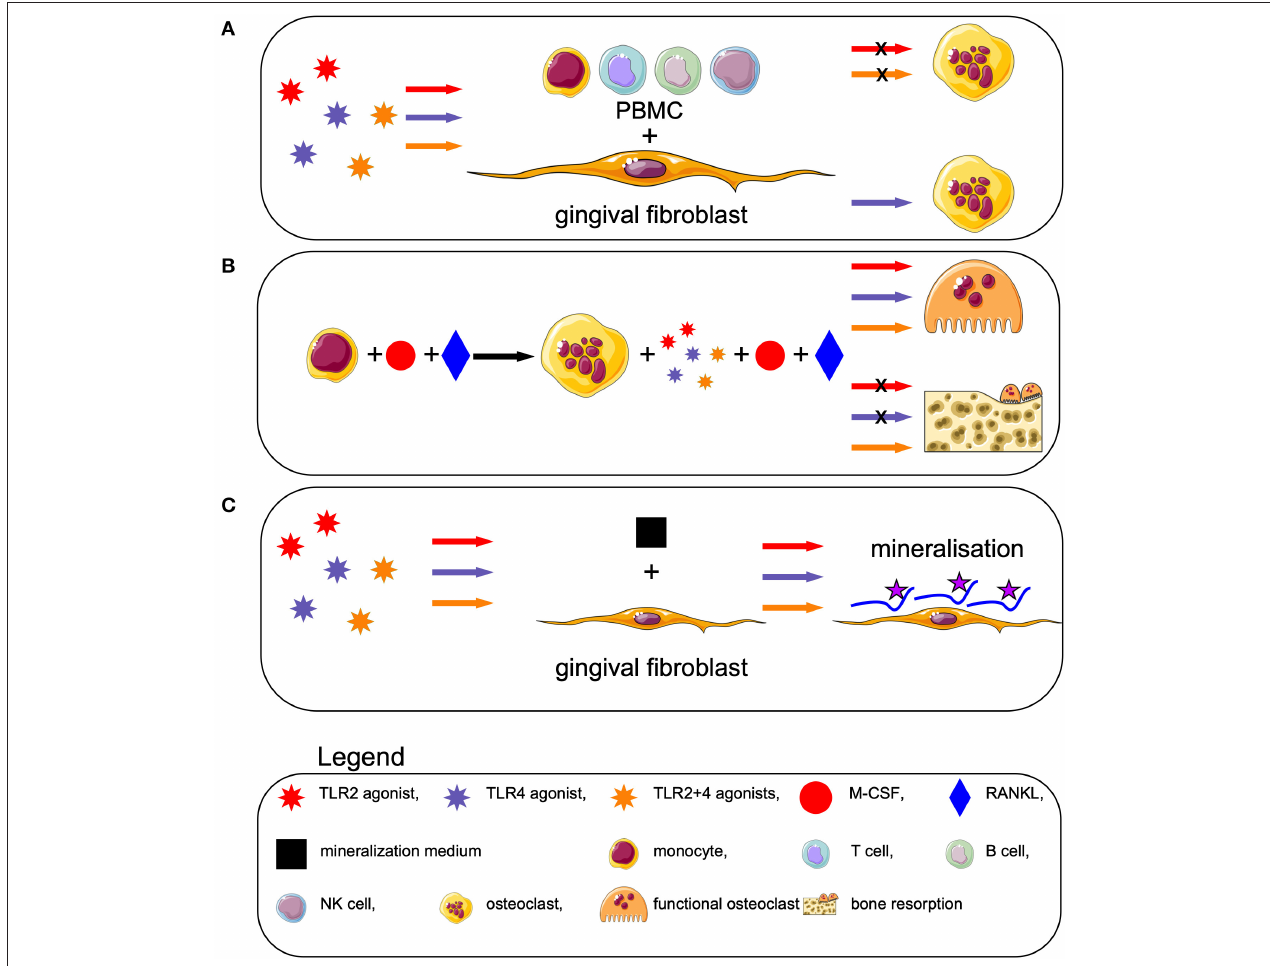
FIGURE 7 | TLR activation affects osteoclastogenesis differently, depending on the differentiation stage of the blood cells, but does not affect osteogenesis. (A) Activation of human peripheral blood mononuclear cells (PBMCs) with TLR2 and TLR2 + 4 agonists, in presence of GF, decreases the formation of osteoclasts. (B) Priming of monocytes with M-CSF + RANKL leads to formation of pre-osteoclast. Triggering of these cells with TLRs in an early stage (from day 7 to 21), concomitant with M-CSF and RANKL, induces formation of bone resorbing osteoclasts. When the TLRs are added on a later stage (from day 14 to 21), the bone resorption capacity of the osteoclasts is reduced. (C) Triggering of GF with TLRs, in presence of mineralization medium, precipitates osteogenesis.